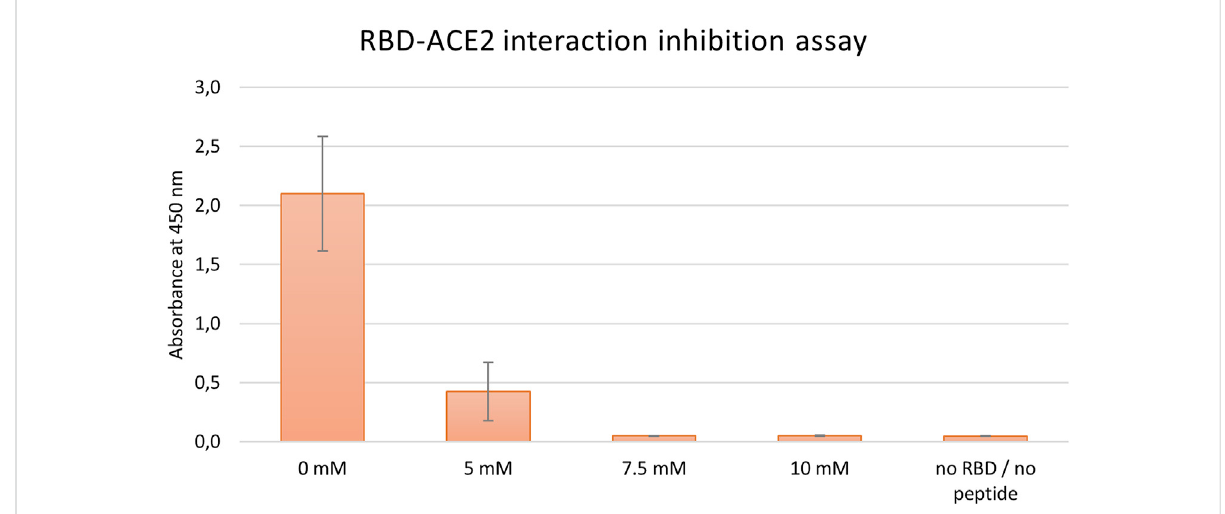
FIGURE 2 InhibitionofSARS-CoV-2-S-RBDbindingto h ACE2byvariousconcentrationsofthepeptideJ3.Graphrepresentsdatafromthreeindependent biological replicates.